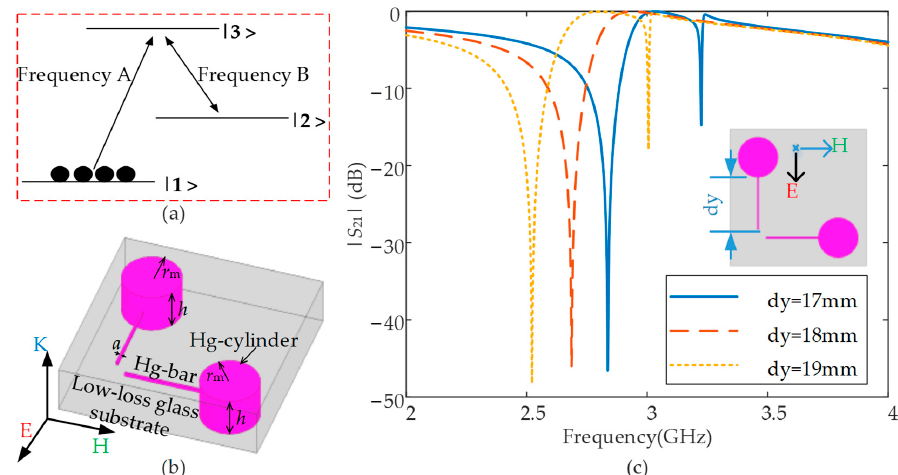
Figure 1. ( a ) Theoretical presentation of the EIT operating mechanism, ( b ) the 3D view of the designed Hg-EIT-like metamaterial unit with parameter definitions, and ( c ) transmission curves of the Hg-EIT-like metamaterial unit under different Hg bar lengths obtained by numerical simulations in the period boundary condition.